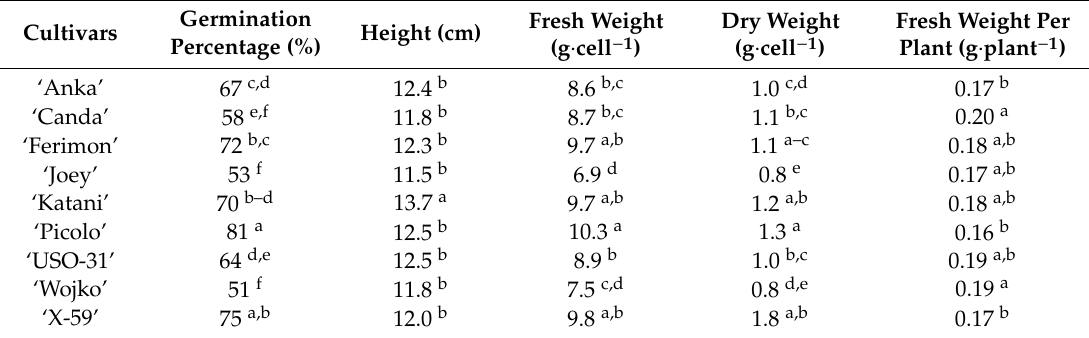
Table 4. Growth parameters of nine baby leaf hemp cultivars. Data represent means of 18 experimental units (3 crop cycles each with 6 experimental units per